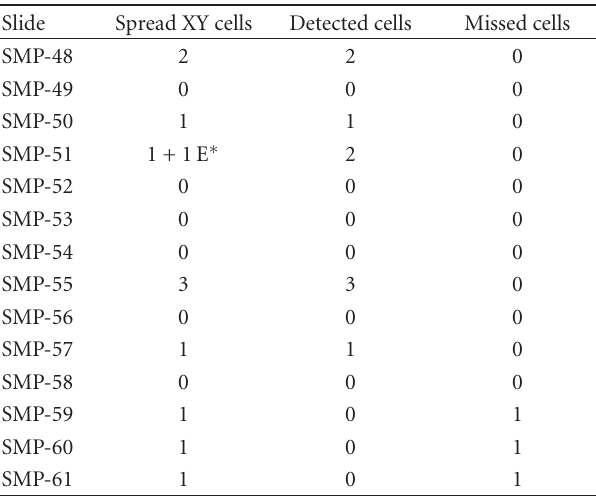
Table 2: Results obtained by manual